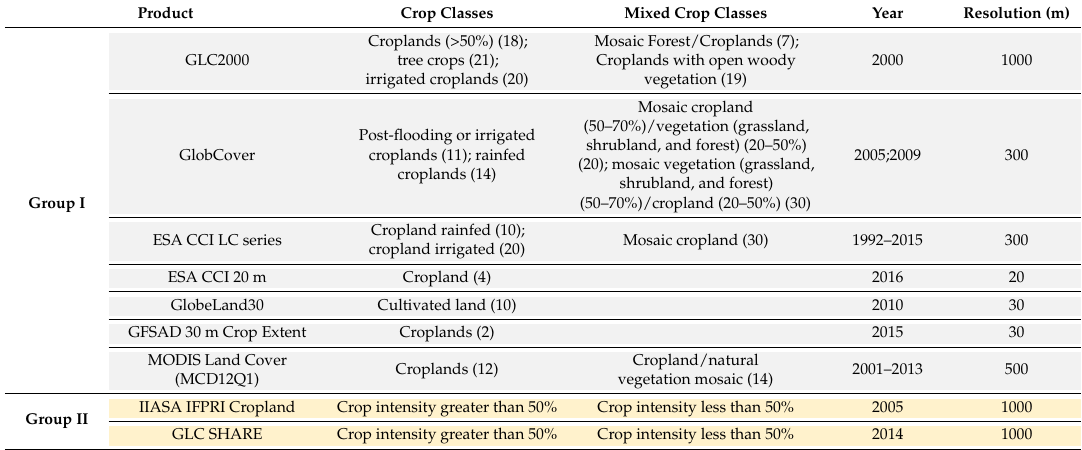
Table 1. Characteristics of the different Land Cover Products Crop classes. The numbers in brackets (e.g., in Cropland (4)), are the class numbers, as reported by the producers. Product Crop